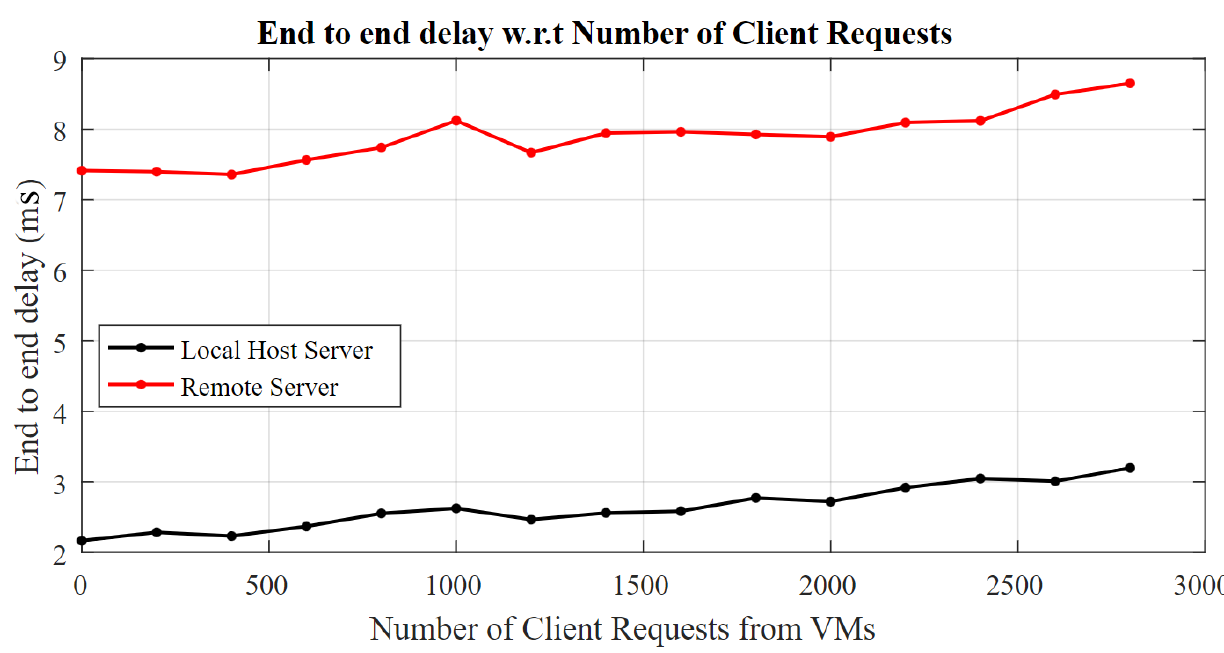
Figure 6. End-to-end delay w.r.t number of client request from connected IoT nodes.